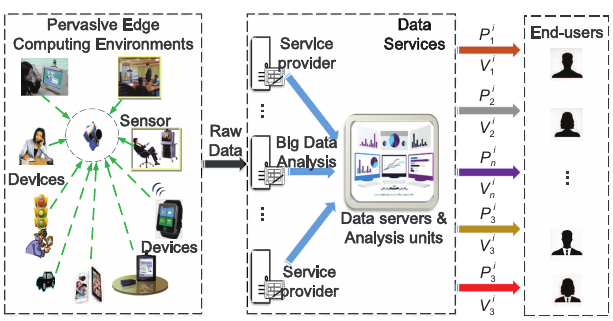
Fig. 1 Big data in the pervasive edge computing environment.